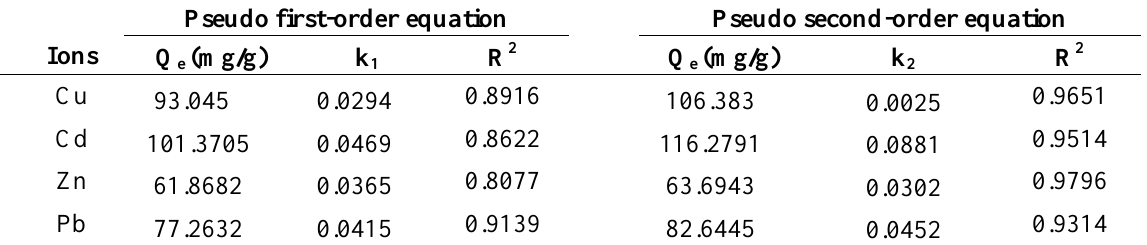
Table 1. Correlation coefficient and correlative parameters of the two rate equations. Pseudo first-order Ions